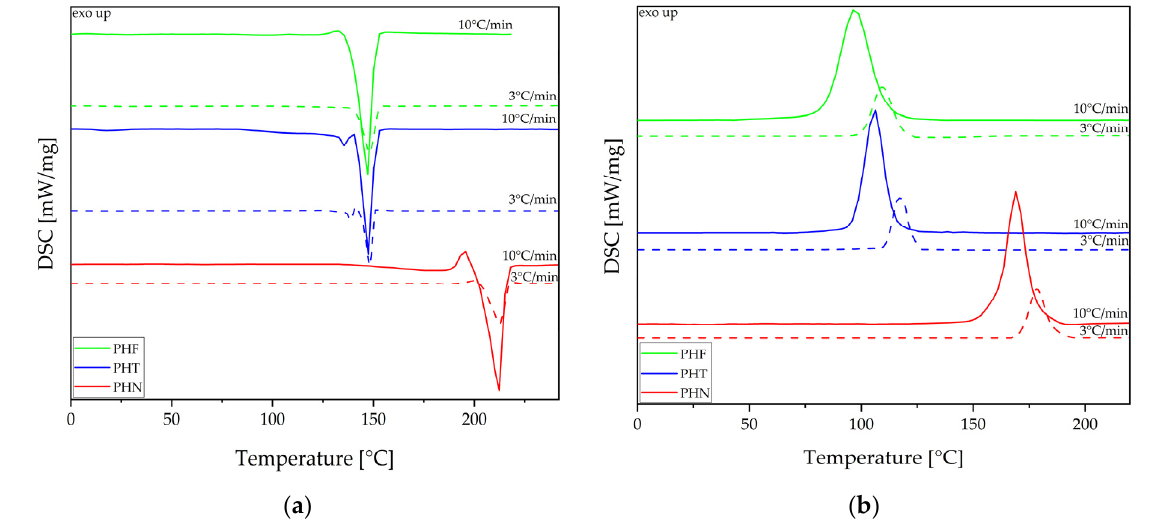
T gR , T gF glass transition temperature of the rigid segment from second heating, and glass transition of the flexible segment from second heating, respectively; ∆ C p , change of heat capacity; T c , ∆ H c , crystallization temperature and the corresponding enthalpy of crystallization; T m , ∆ H m , melting temperature and the corresponding enthalpy of melting.